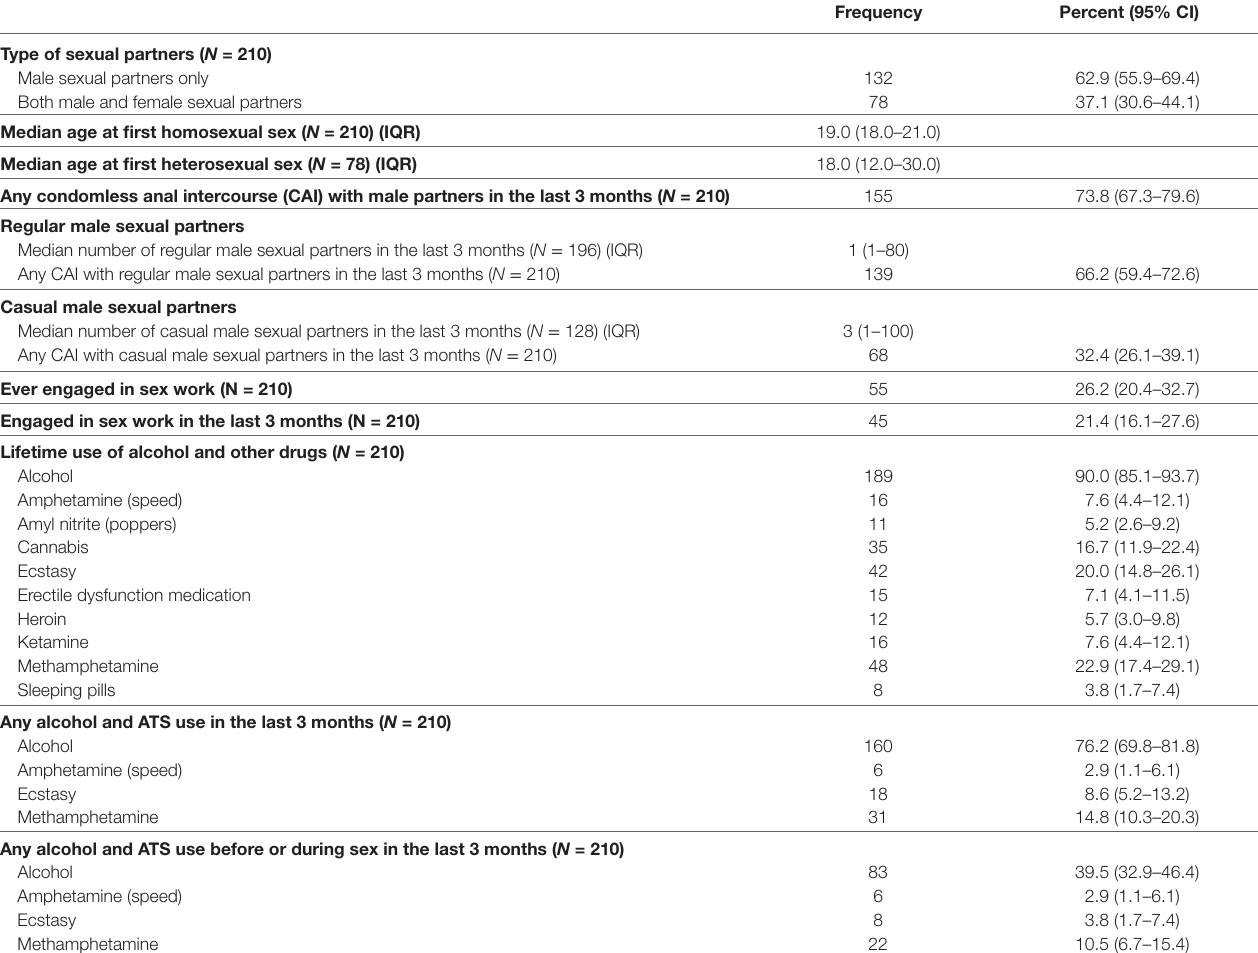
TaBle 2 | sexual and drug use behaviors.